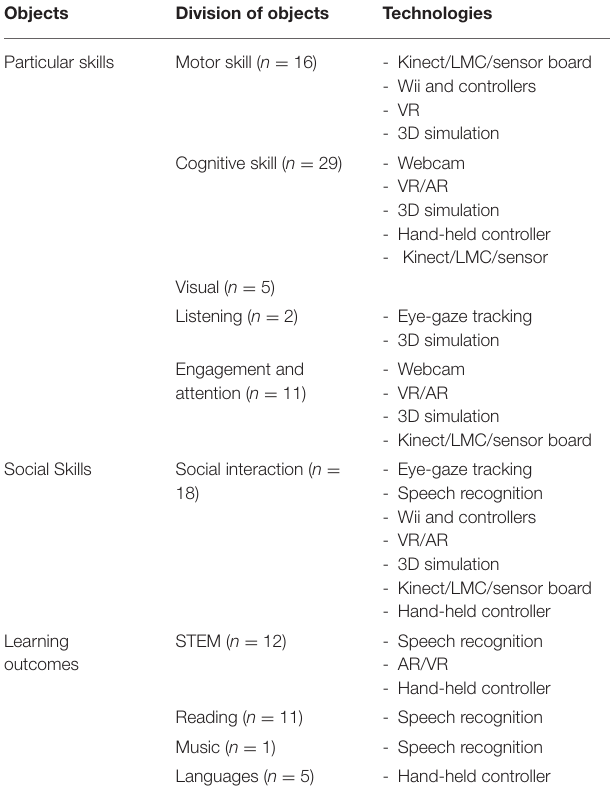
TABLE 4 | Learning objectives with different types of technology.